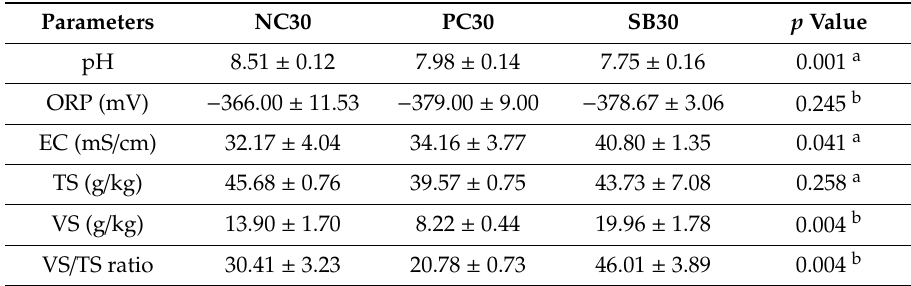
Table 2. Chemical characteristic of the treatments at day 30.